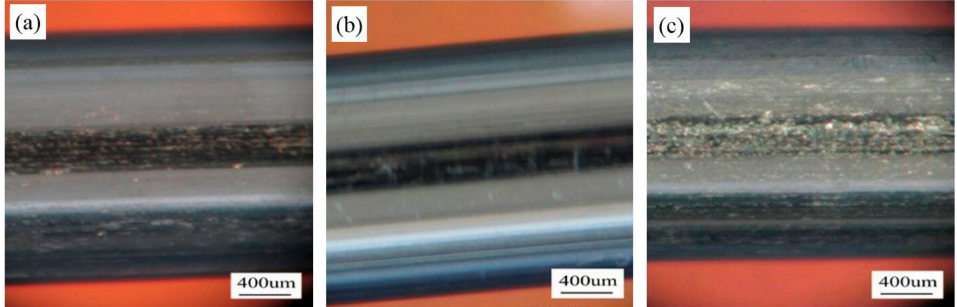
Figure 7. Roughness of 1.2 mm Al-5Mg- x Zr wire electrodes: ( a ) x = 0; ( b ) x = 0.12; ( c ) x = 0.5.